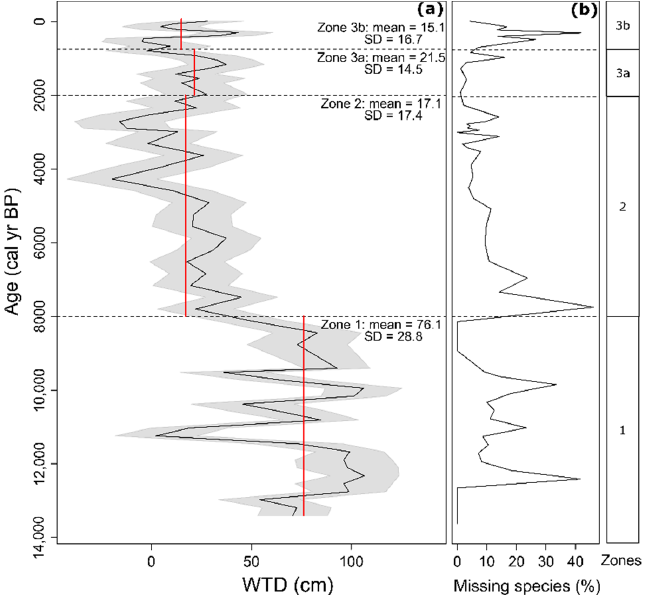
Figure 3. Reconstruction of water table depth (WTD, cm) based on morphospecies data ( a ) and quality of the reconstruction ( b ) estimated as abundance sum (%) of species missing from the training set (the greater abundance sums of species missing from the training set, the less reliable the reconstructed WTD values; generally, a cut-off value of 15% for good representativeness can be applied). The zonation is based on the constrained cluster analysis of the morphospecies composition of testate amoeba communities (see Figure